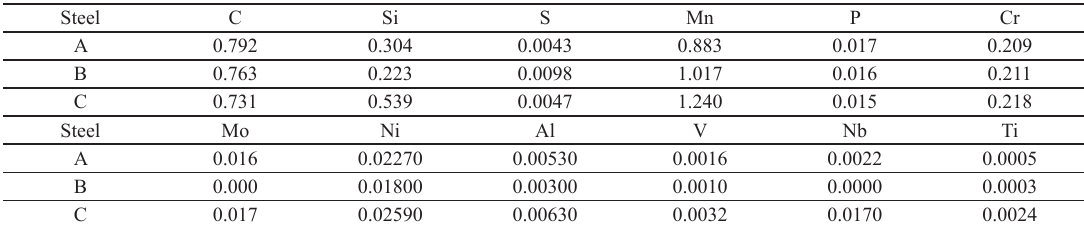
Table 1. Chemical compositions of the studied steels